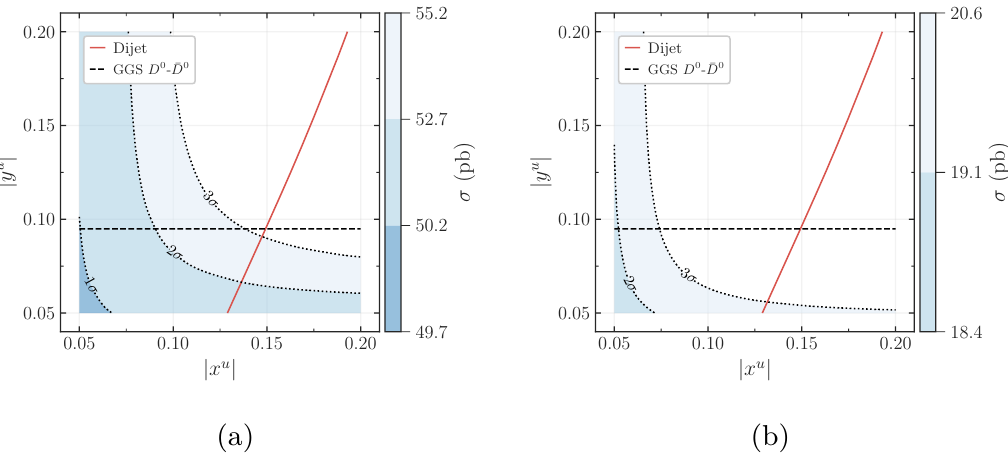
Figure 8 . Theoretical predictions of the total STP cross section (cid:27) at p s = 8 TeV including the contributions of the diquark D u with M D u = 600 GeV. Results are shown for di(cid:11)erent top transverse momentum p T ( t ) intervals, where the minimum values for p T ( t ) are (a) 50 GeV and (b) 100 GeV, both having a maximum value of 300 GeV. The central value (cid:27) exp of the experimental measurement is shown (black solid line), as are the 1 (cid:27) , 2 (cid:27) and 3 (cid:27) regions (black dotted lines). Constraints from D 0 - (cid:22) D 0 mixing (black dashed line) [39] and direct searches (red solid line) from section 4 are also